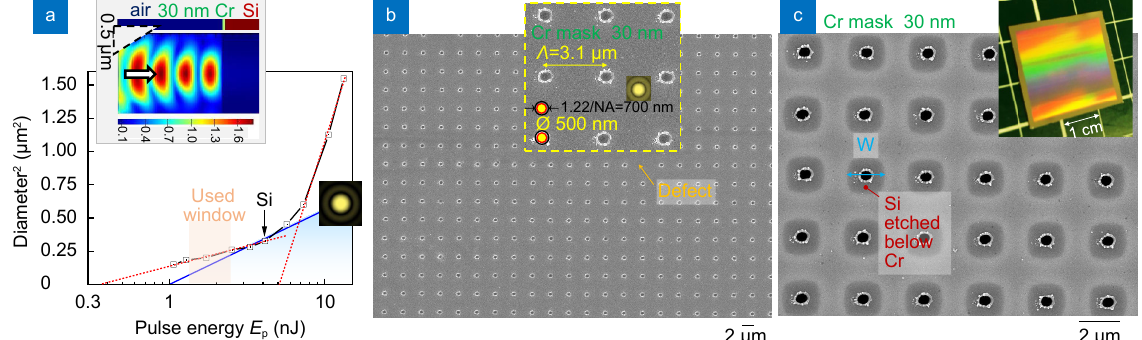
Fig. 2 | Cr etch mask defined by direct laser writing. ( a ) Calibration of the ablated hole diameter D 2 ∝ ln( E p ) vs. the pulse energy E p . The threshold 0.36 nJ (0.09 J/cm 2 , 0.41 TW/cm 2 ) and 5.15 nJ (1.35 J/cm 2 , 5.85 TW/cm 2 ) are the intersections of dashed-lines with x -axis. The solid- line is expected evolution of D 2 defined by the beam waist r = 0.61 λ / NA . Top-inset shows light field E simulations for the NA = 0.9 focusing used with a Cr film on Si, for λ = 515 nm; the finite difference time domain (FDTD, Lumerical) was used. ( b ) SEM image of the ablated 30 nm Cr film; E p = 1.7 nJ. The inset shows a closeup view of the ablated holes in the Cr film; the thumbnail image of the Airy pattern of the focal spot is scale matched. ( c ) SEM image of sample after 10 min plasma etch. The contrast change reveals the width W of the plasma etched Si (SF 6 :CHF 3 :O 2 at 5:1:1 flow rate ratio). The inset shows photo of 2 × 2 cm 2 area of ablated Cr mask on Si (before